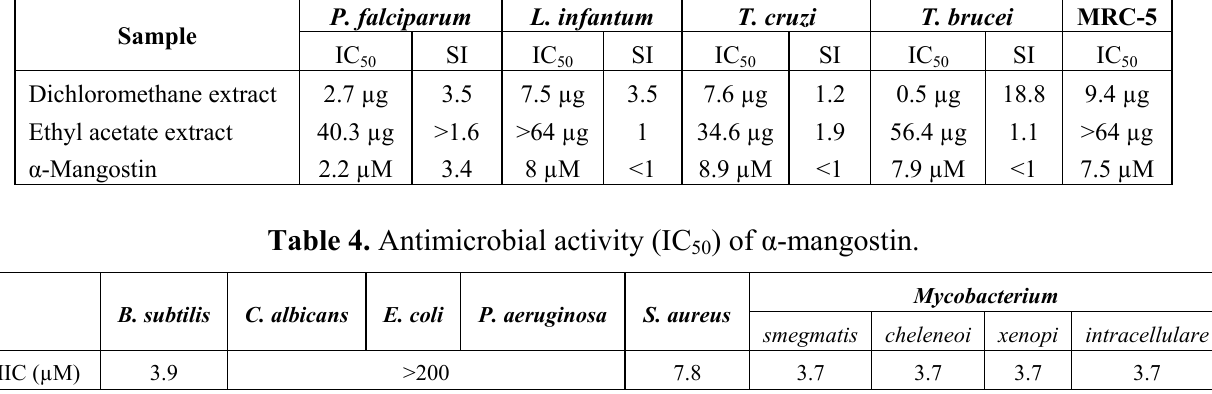
Table 3 . Antiprotozoal activity of G. mangostana extracts and α -mangostin. Sample